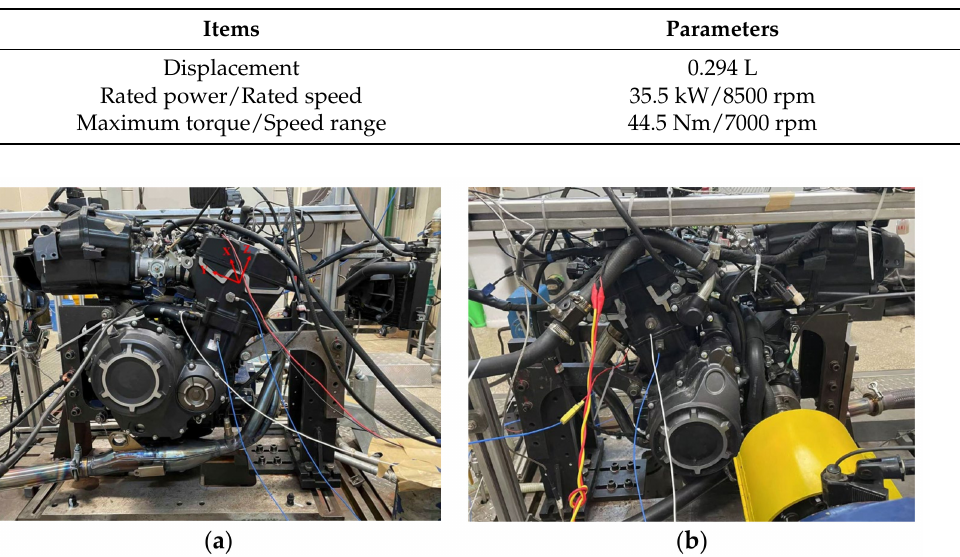
Table 9. Parameters of gasoline engine.